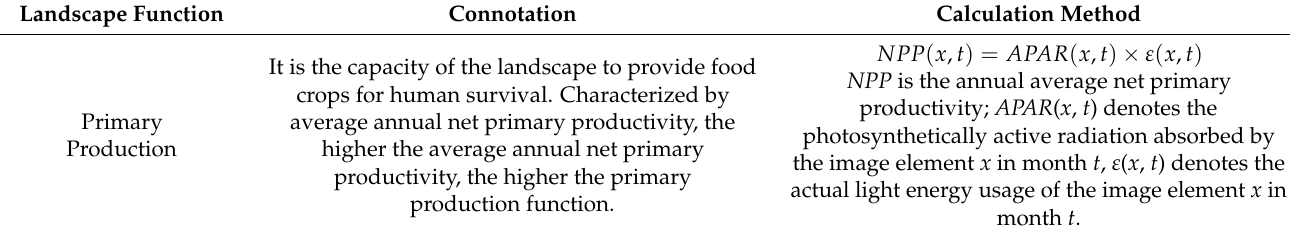
Table 1. Indicators and methods of landscape function